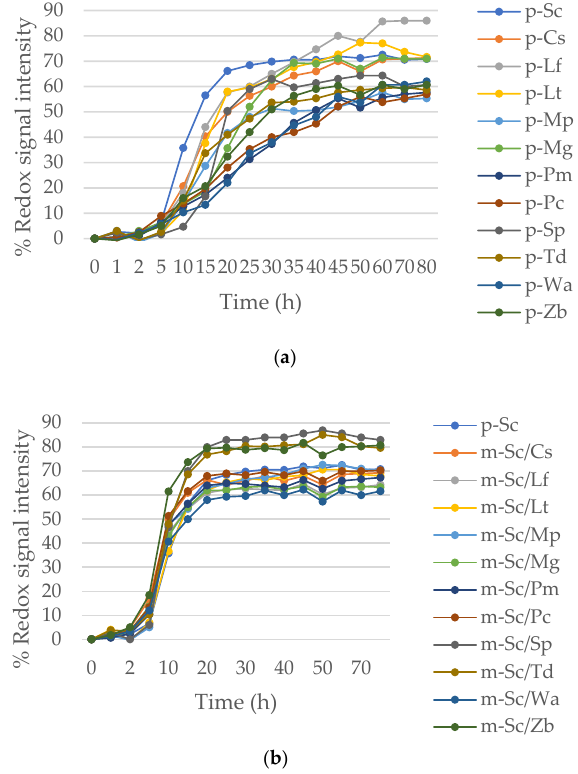
Figure 4. Metabolic rate as redox signal intensity of non- Saccharomyces strains and S. cerevisiae under high osmotic stress induced by 30% sorbitol in: ( a ) pure culture and ( b ) mixed culture 1:1 with S.